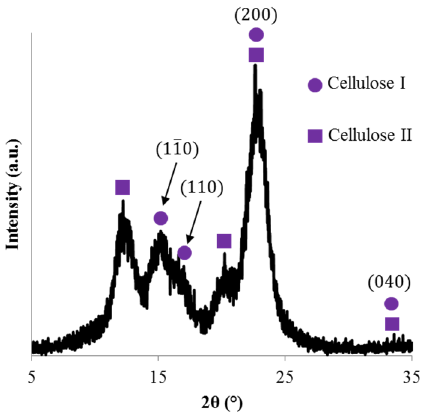
Figure 4. Diffraction pattern of a CNC mat with cellulose I and cellulose II primary diffraction peaks indicated.